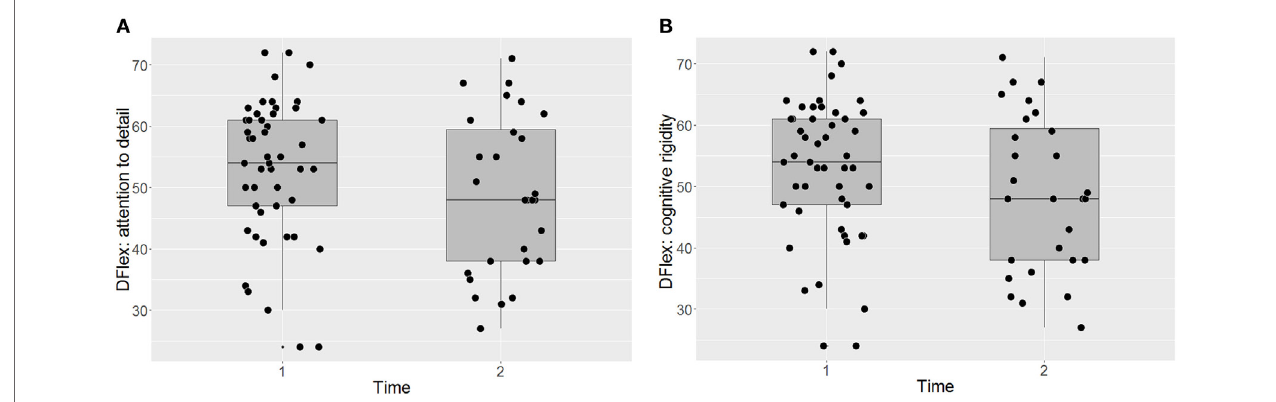
FigUre 2 | Self-report assessments of attention to detail ( a ) and cognitive flexibility ( B ) before and after CRT. Dflex, Detail and Flexibility Questionnaire; CRT, cognitive remediation therapy; Time 1, before cognitive remediation therapy; Time 2, end of cognitive remediation